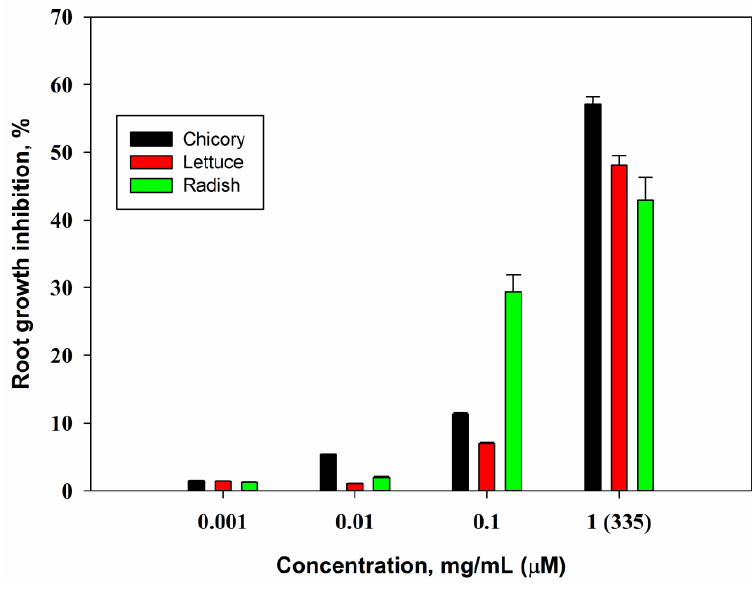
Figure 4. Phytotoxic activity of phaeosphaeride A in the root inhibition bioassay. Bars indicate standard deviation at p = 0.05.